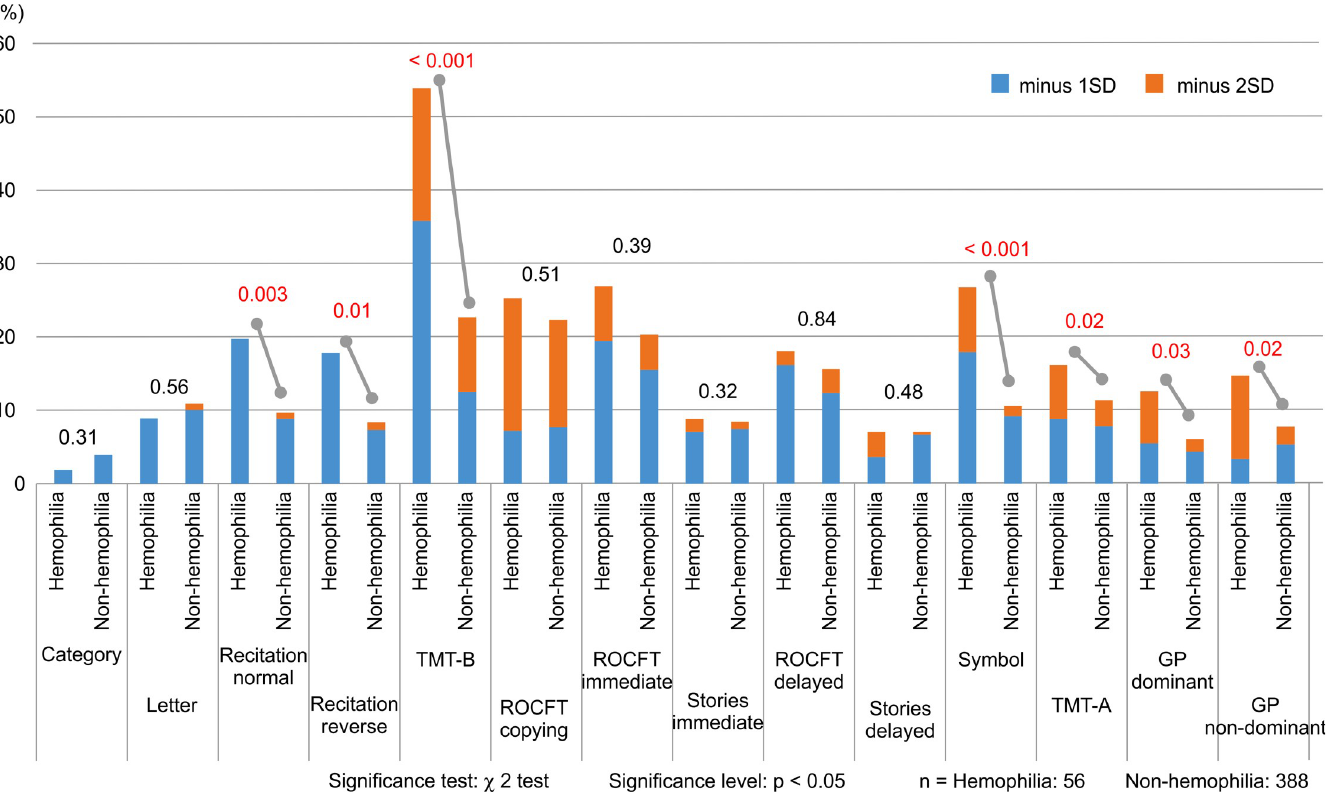
Fig 2. Comparison of the proportions of low scores (at least 1SD below the mean) on psychological testing. A comparison of the proportions of low scores (at least 1SD below the mean on standardized neuropsychological tests) showed that recitation in normal order, recitation in reverse order, TMT-B, symbol, TMT-A, GP (dominant hand), and GP (non-dominant hand) were significantly higher in the hemophilia group than in the non-hemophilia group. Abbreviations: SD, standard deviation; TMT, Trail Making Test; ROCFT, Rey-Osterreith Complex Figure Test; GP, Grooved Pegboard.